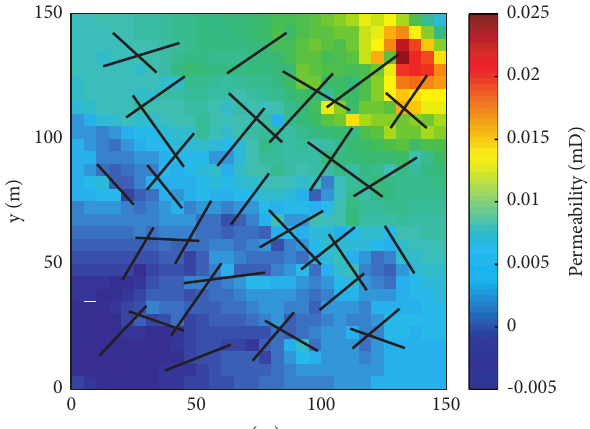
Figure 30: Permeability difference between the pIEDFM and EDFM